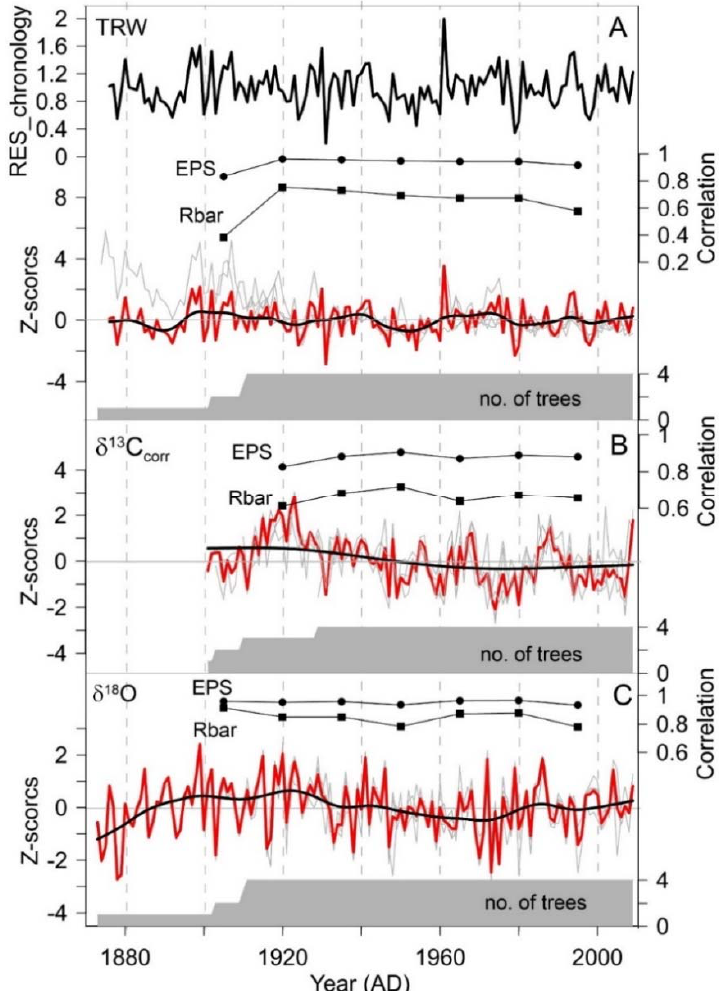
Figure 4. ( A ) The TRW chronology of four trees (thin gray lines), average (solid red line) and 9-year cubic-smoothing splines (black line), EPS (black line and circle), Rbar (black line and rectangle), and the residual chronology (thick black line) at the top panel; ( B ) tree-ring δ 13 C TR of four trees (thin grey line), average (solid red line), and 9-year cubic-smoothing splines (black line); ( C ) tree-ring δ 18 O of four trees (thin grey line), average (solid red line) and 9-year cubic-smoothing splines (black line), the number of trees (solid gray bar graph).